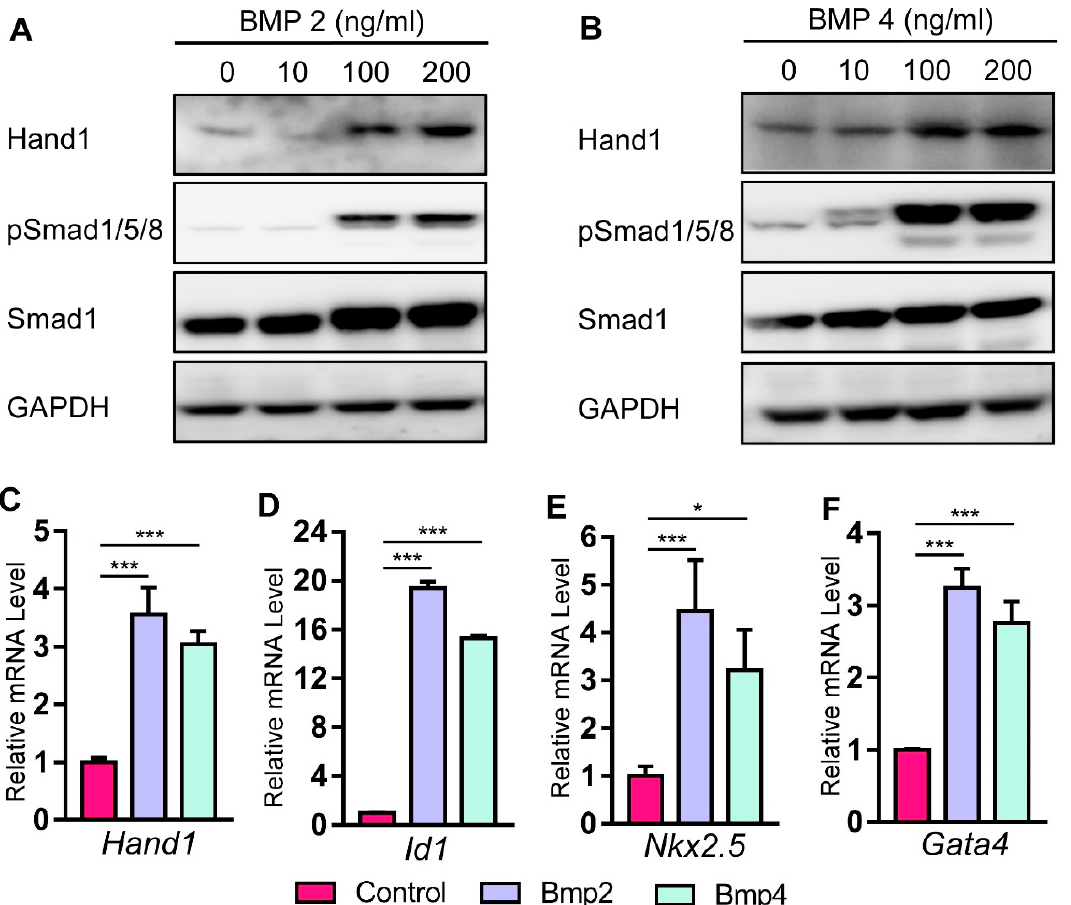
Figure 4. Bmp2 and Bmp4 induce Hand1 expression in P19 cells. ( A , B ) P19 cells were stimulated with Bmp2 and 4 for 6 days. Levels of Hand1 were analyzed by western blotting. ( C – F ) Total RNA was harvested on day 6 with Bmp treatment for 6 days (100 ng/mL). qRT-PCR was performed for the analysis of Hand1 , Id1 , Nkx2.5 , and Gata4 mRNA. Data are presented as means ± s.e.m. * indicates p -value < 0.05, *** indicates p -value < 0.001.